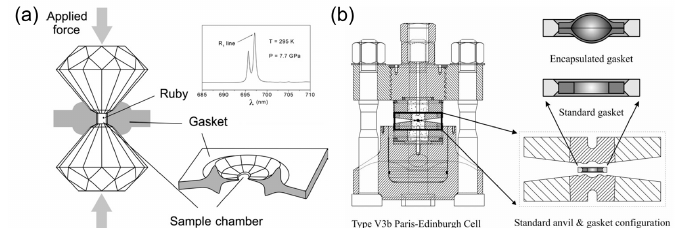
Figure 1. ( a ) The assembling of diamond anvil cell (DAC) and its sample chamber. A ruby chip is placed in the sample chamber for the local pressure calibration [17]. ( b ) The structure of PE cell with its anvil and gasket